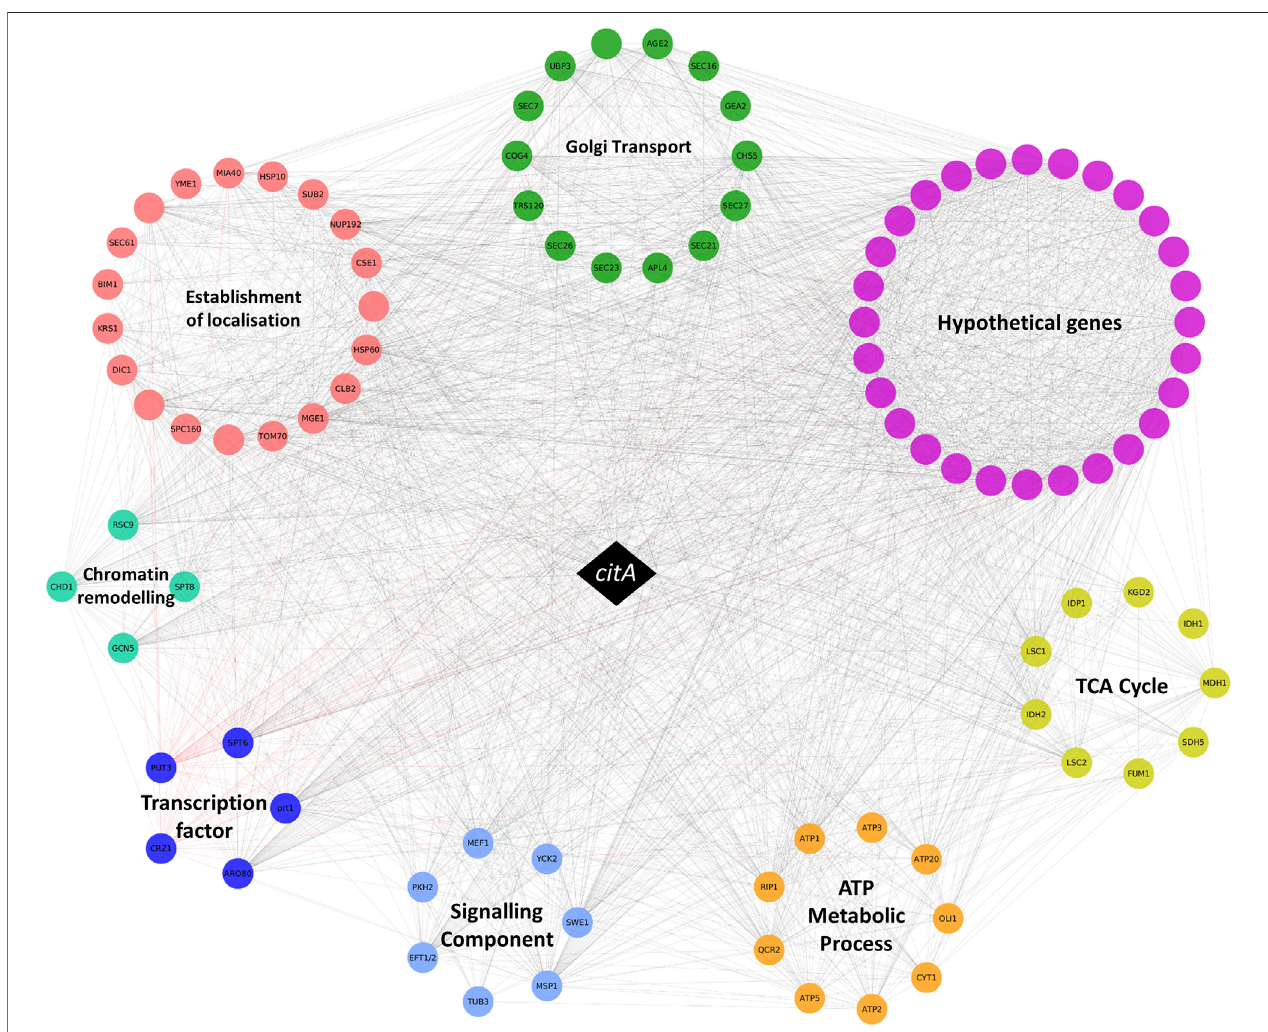
FIGURE 1 | Schematic representation of the citA coexpression network. The citA gene is represented by a black diamond, and other genes are represented by coloured circles which are grouped into functional categories. Coexpression coef fi cients greater than 0.7 are depicted with grey lines. Gene names are given where available-genes lacking a name are blank, and full ORF codes are given in Supplementary Tables S1, S2 .